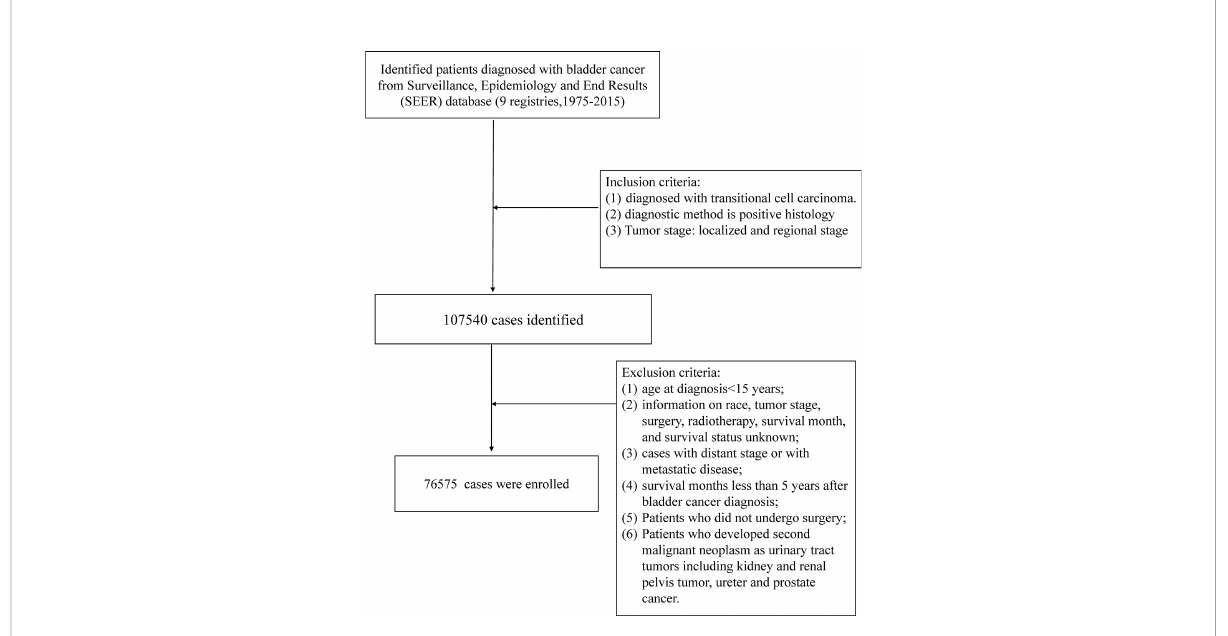
FIGURE 1 Flow chart for screening patients with bladder cancer treated with